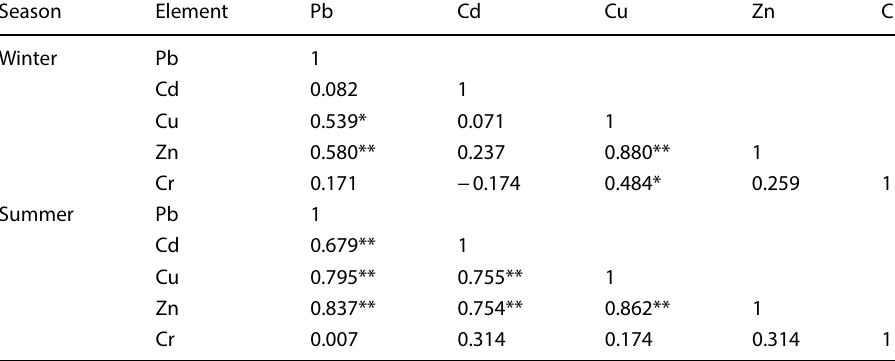
* and **Significant level at P < 0.05, 0.01 level, respectively ( n